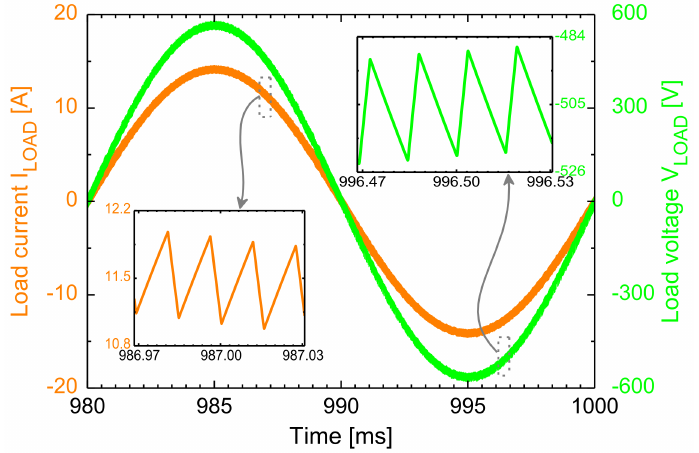
Figure 12. Simulated I LOAD (orange curve) and V LOAD (green) vs. time in the last 20 ms window. Magnifications highlighting the ripple of I LOAD and V LOAD in four-period-long windows are also reported on the bottom-left and top-right corners, respectively.